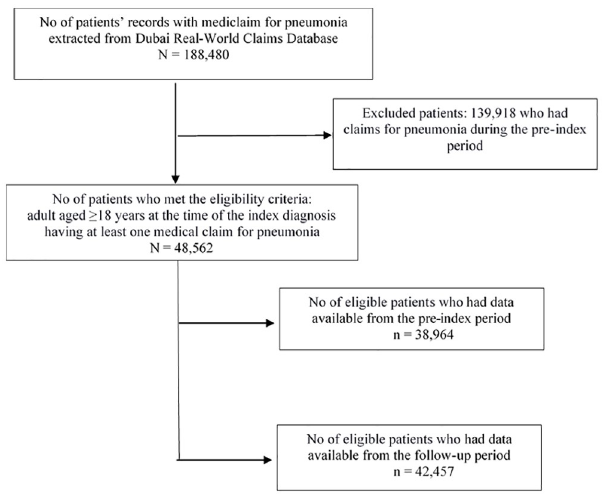
Fig 2. Patient disposition flow chart. Index diagnosis is defined as the date of first diagnosis for pneumonia; pre- index period is the 12-month period prior to index diagnosis; follow-up period is the 12-month period after index